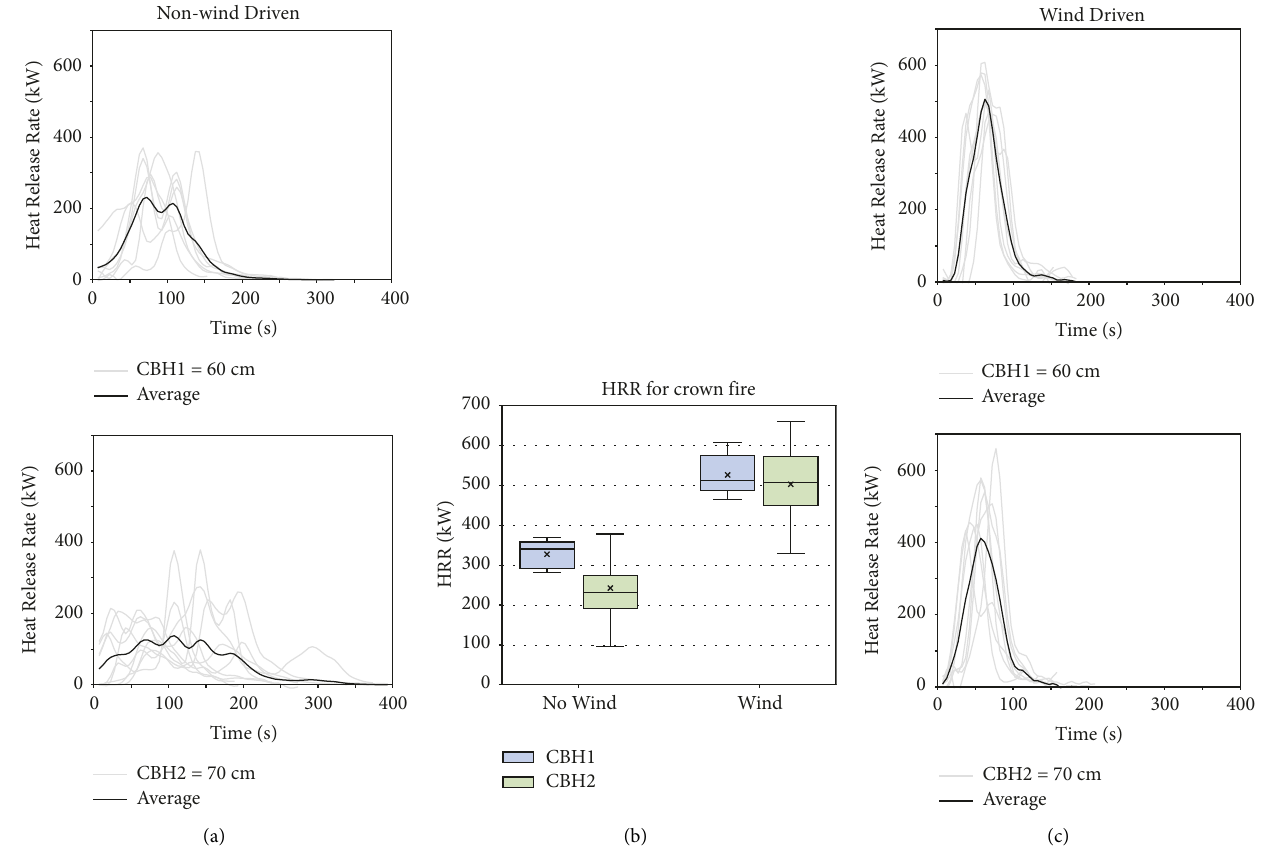
Figure 4: Crown fire heat release rate in nonwind-driven fires (a), wind-driven fires (c), and the box and whisker plot with average heat release rate for all experiments (b). For the box plot, the cross represents the mean, the horizontal bar represents the median, the bottom of the box represents the 25th percentile, the top of the box represents the 75th percentile, the bottom of the whisker is the minimum data point, and the top of the whisker is the maximum data